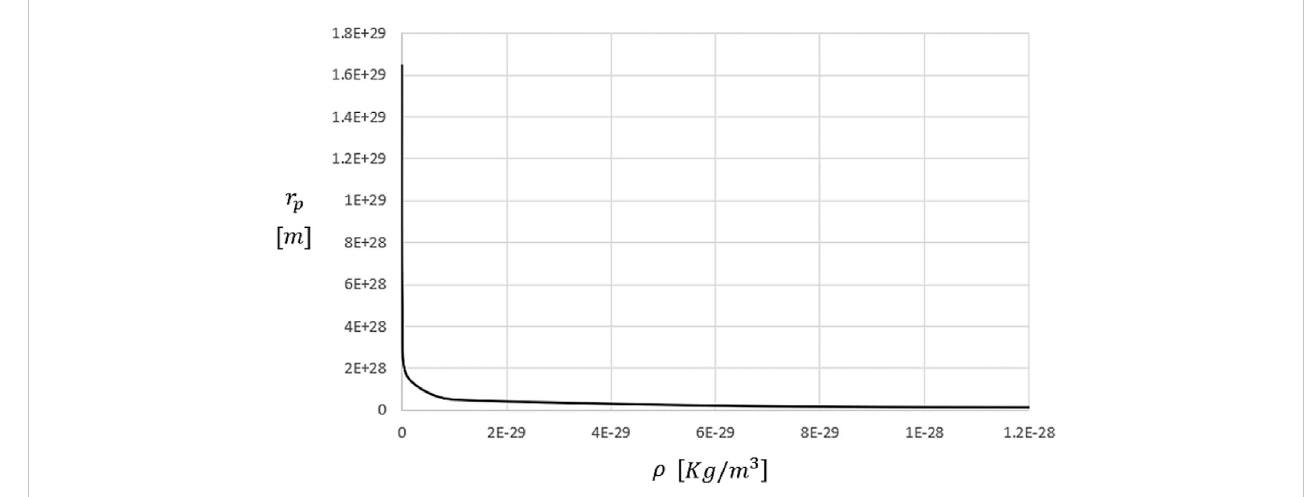
FIGURE 9 Threshold distance varying with the density of matter in the Universe.